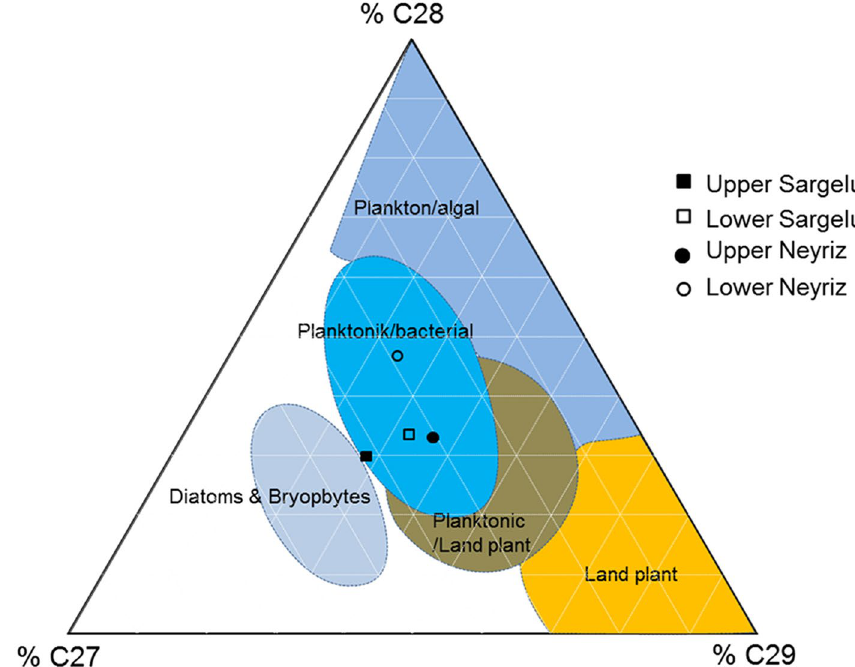
Fig. 11 Ternary diagram of C27, C28, and C29 steranes, which shows the origin of organic matter (modified from Huang and Meinschein 1979)